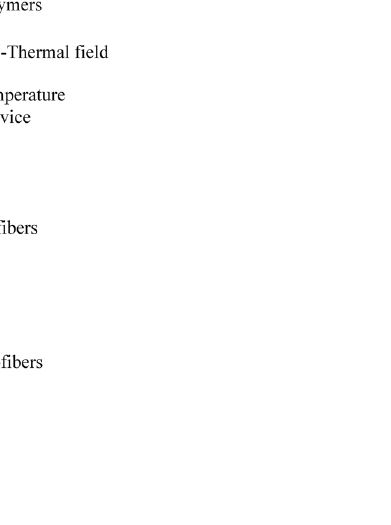
Figure 1. Schematic diagram of MES